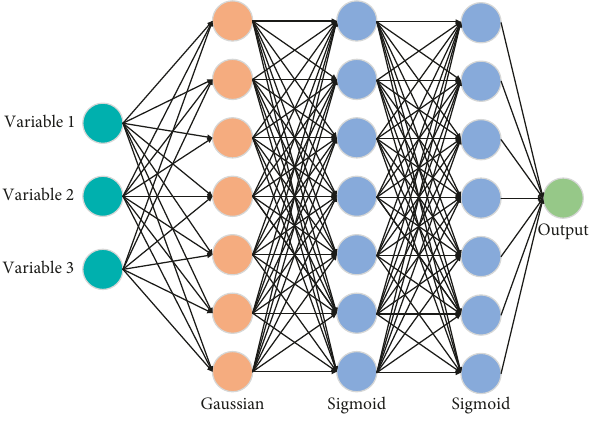
Figure 5: RBF-BP neural network model.